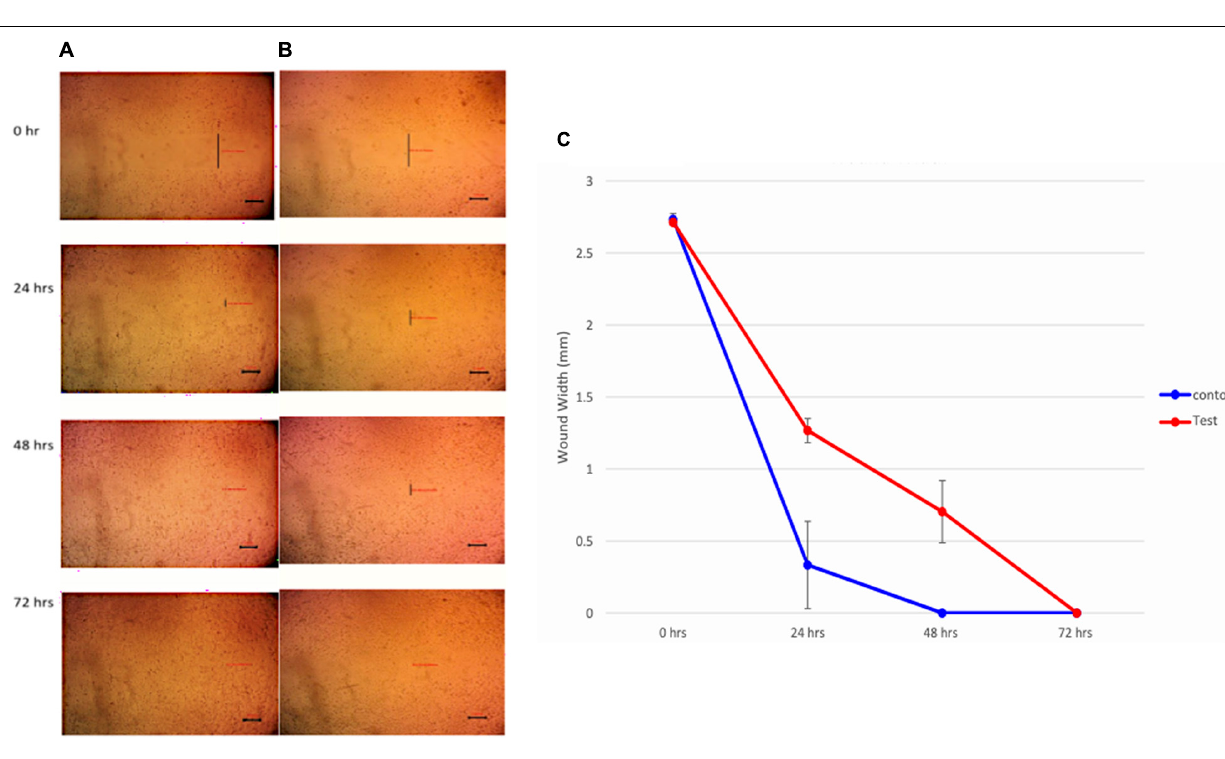
FIGURE 2 | Images of scratch closure rate (A) control without melanin, (B) test with 100 µ g/ml melanin, and (C) wound width calculated as the distance between the edges of the scratches at various time